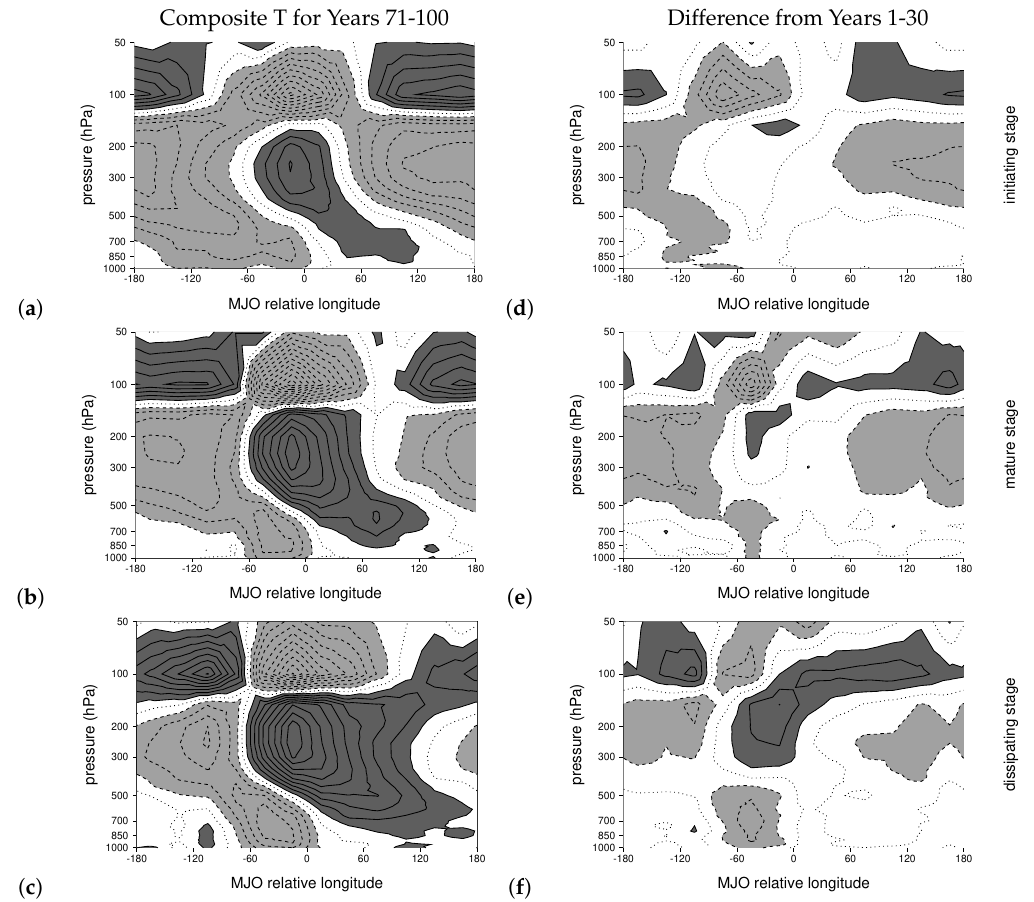
Figure 11. The change in MJO temperature perturbations during the course of the simulation. ( a – c ) Year 71–100 composite MJO temperature perturbations for the initiating, mature, and dissipating stages respectively. ( d – f ) The difference between Year 71–100 temperature perturbations and those for Years 1–30 for the initiating, mature, and dissipating stages respectively. Contoured as in Figure 7. Table 1. Pattern correlation and amplitude increase for composite MJO fields between first and